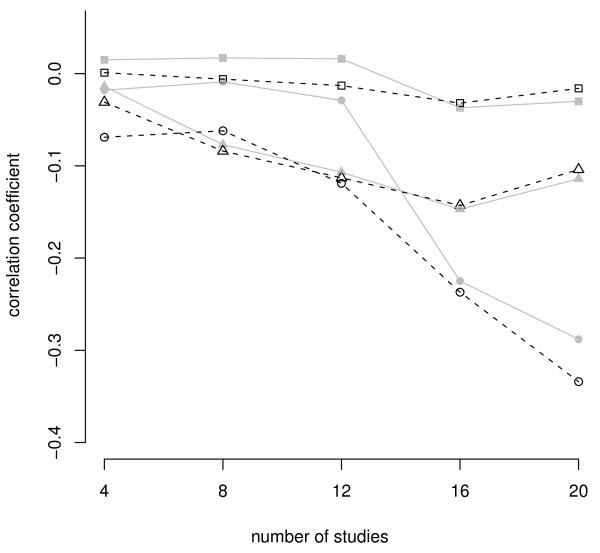
Coefficients of correlation between replicability and FST for the 890 associations from the Global Set. Values correspond to Spearman correlation coefficients (ρ). The replicability is measured in % of positive studies over total studies and the genetic differentiation values correspond to average FST values between Europeans and East Asians, under different pooling conditions. X-axis values indicate the cutoff of number of studies per associations, filtering out those associations with fewer studies than indicated. Solid grey lines correspond to the Full Set of associations. Dashed lines correspond to associations from the Conservative Set (replicability ≥50% in at least one continent). Circles, triangles and squares correspond to FST values computed from average of the SNPs in a gene, individual SNPs and tagSNPs, respectively.